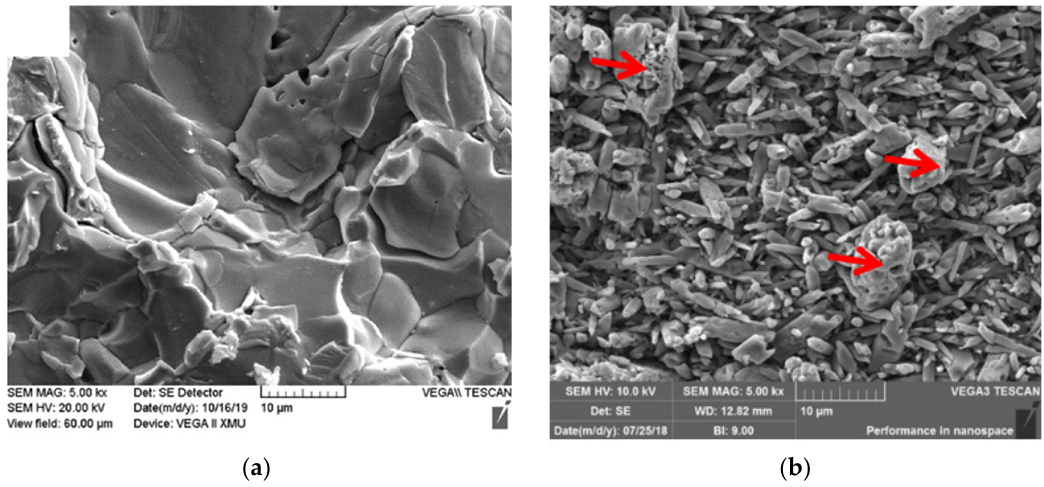
Figure 5. Microstructure of metal layer ( a ) and ceramic matrix ( b ) in 9SM-laminated composites.